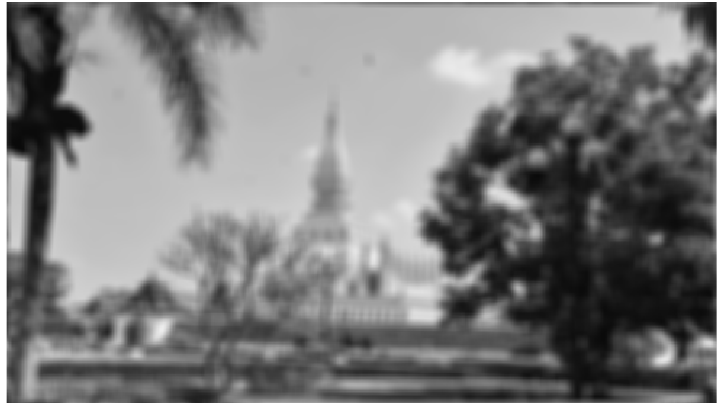
Figure 10. Three degraded grey image by blurred matrices A 1 , A 2 , and A 3 ,